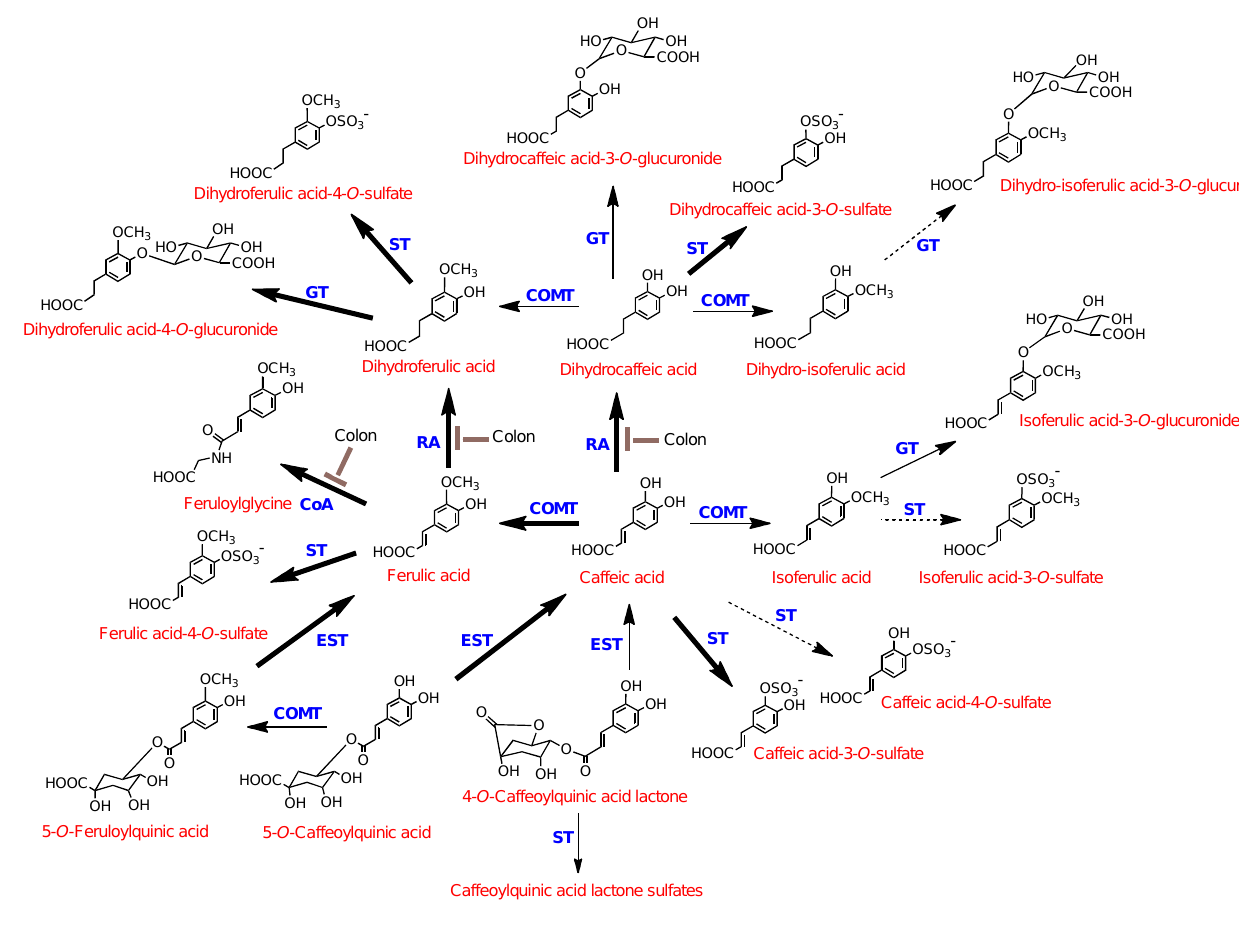
Figure 3. Proposed metabolism of chlorogenic acids following the ingestion of coffee by human volunteers. 5- O -CQA and 5- O -FQA are illustrated structures but their respective 3- and 4-isomers would be metabolized in a similar manner and likewise with 4- O -CQAL and 3- O -CQAL. COMT, catechol- O -methyltransferase; ET, esterase; RA, reductase; GT, UDP-glucuronyltransferase; ST, sulfuryltransferase; Co-A, co-enzyme A. Bold arrows indicate major routes, dotted arrows minor pathways. Steps blocked in subjects with an ileostomy and hence occurring in the colon are